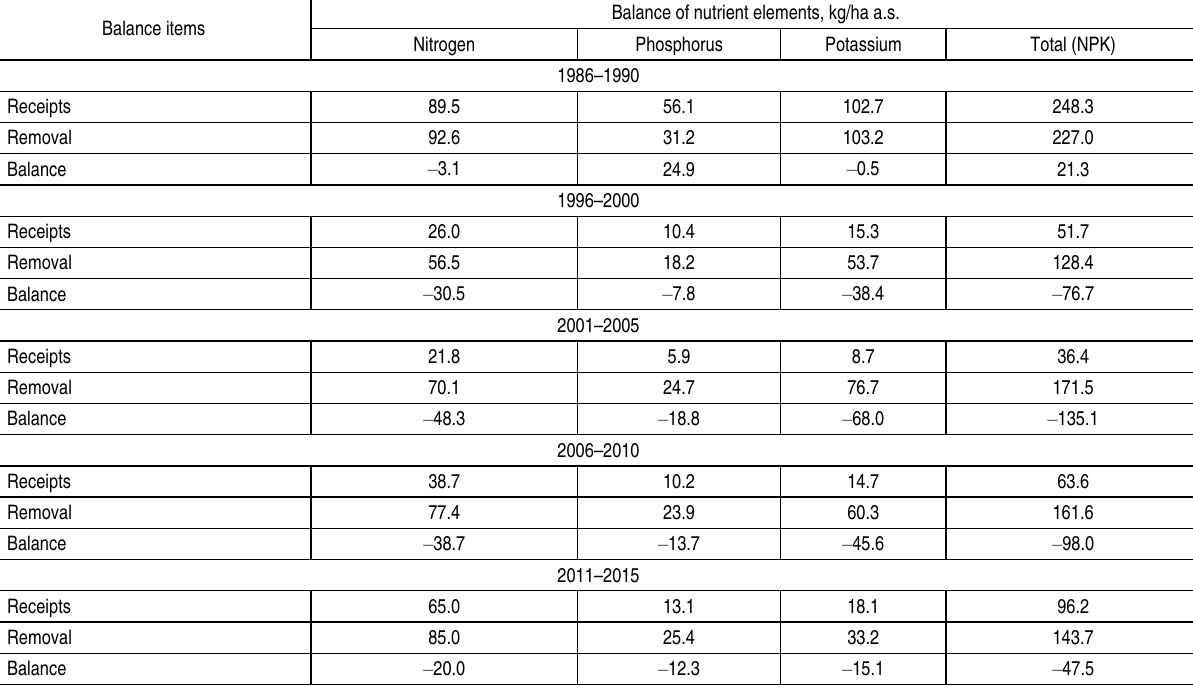
Table 2. Dynamics of the balance of nutrient elements in agriculture in Ukraine Balance items